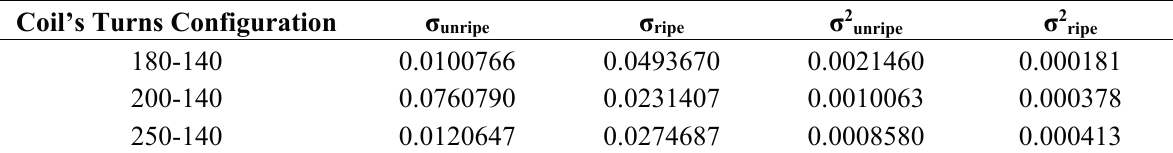
Table 5. Standard deviation and variance for ripe and unripe vs. air.